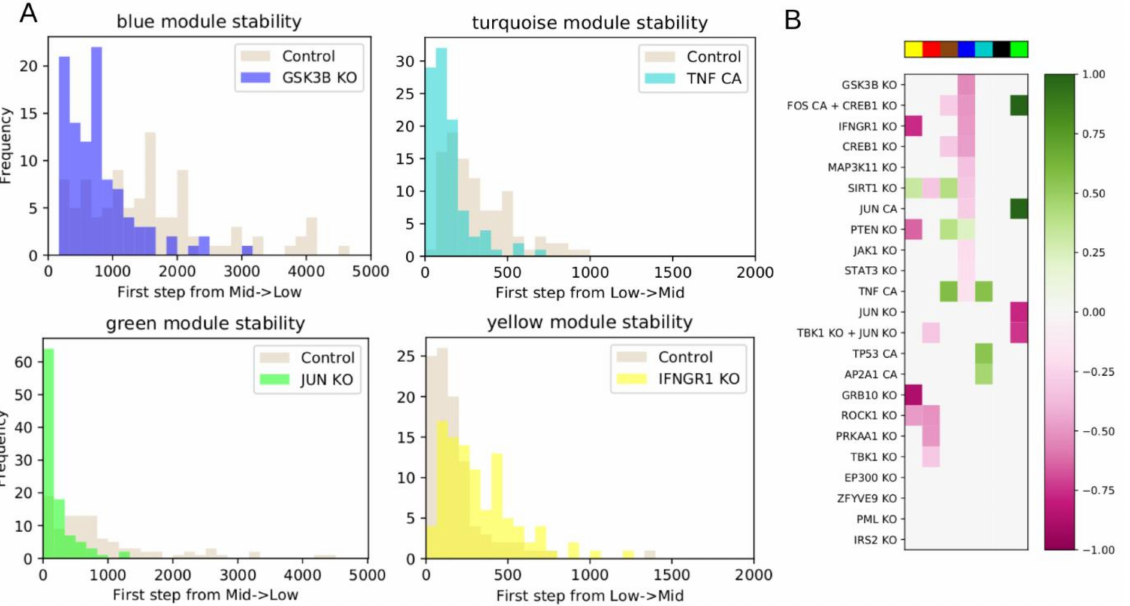
Figure 5. Targeted interventions of driver nodes cause up- or down-regulation of gene modules. ( A ) Distribution of the number of steps required for the module to switch between low and intermediate activation. The distributions in beige show the dynamics of the system with no manipulations, while the colored distributions show the manipulated systems. For modules transitioning from low to intermediate activation, an intervention shifting the distribution to a longer time to switch (rightward shift) maintains the module in the downregulated state, while a leftward shift upregulates the module. For modules transitioning from intermediate to low, a rightward shift indicates the module is maintained in an upregulated state, while a leftward shift indicates downregulation. ( B ) Heatmap showing the up- or down-regulation of statistically significant interventions (two-sided Mann–Whitney U Test, FDR-adjusted p -value < 0.05) compared to control for each module. Only significant interventions are colored. Colors are scaled so that a value of +/ − 1 indicates a 100% relative shift in mean transition time compared to